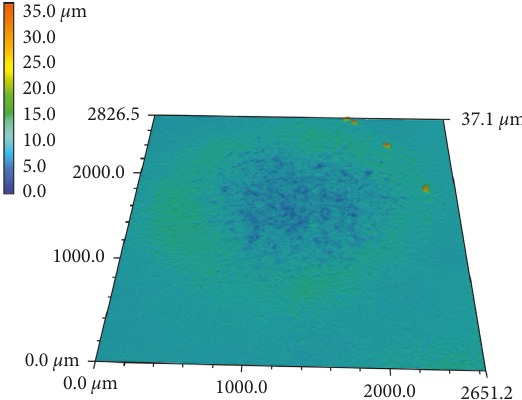
Figure 13: The erosion surface morphology of quartz glass by using the fragile removal method ( P Plane view. (b) 3D view.